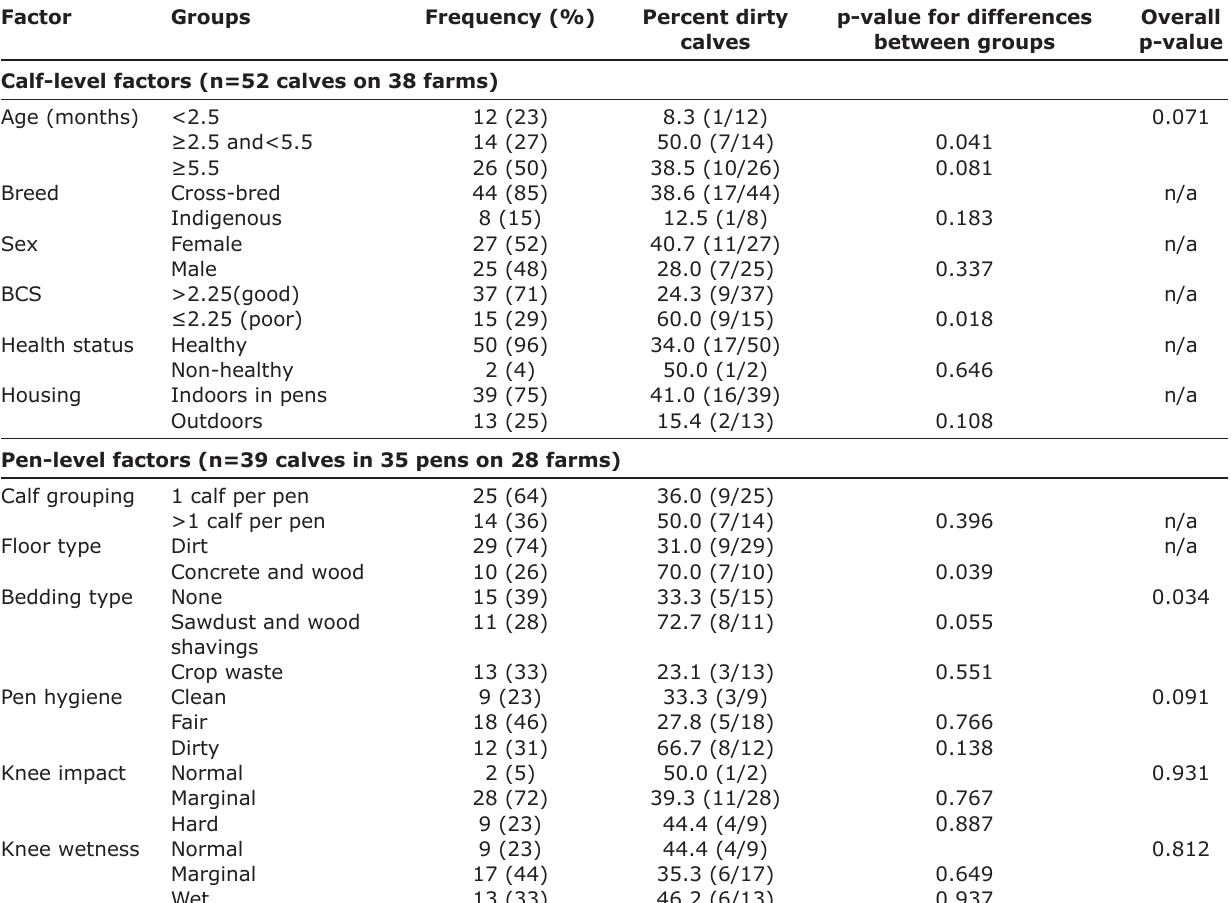
Table-1: Calf- and pen-level characteristics of calves in 38 smallholder dairy farms in Meru County, Kenya, 2017, along with the relative proportions and P values associated with dirty leg hygiene scores in calves. Factor Groups p-value for differences